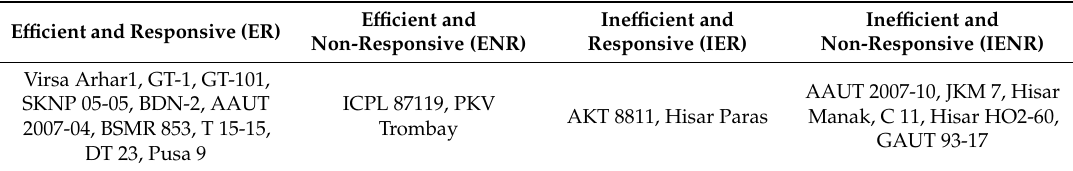
Table 6. Categories of pigeonpea genotypes for zinc (Zn) e ffi